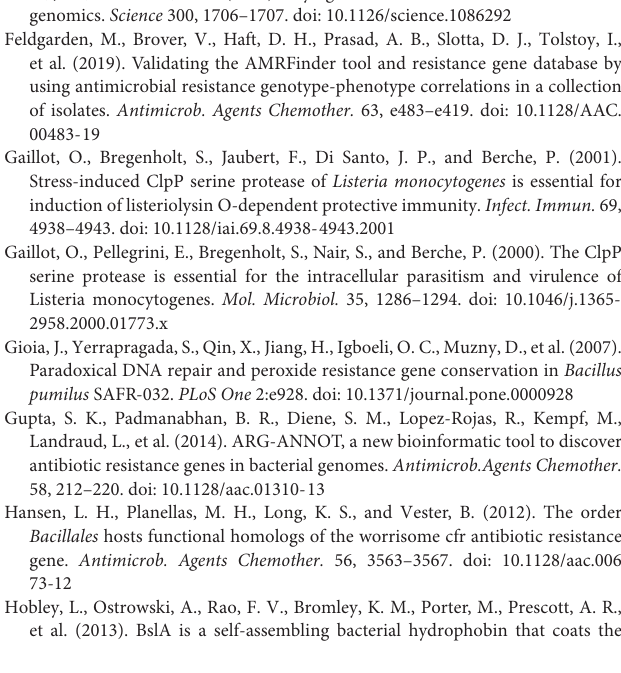
Supplementary Figure 1 | A flow chart representation of analyses conducted by different modules of PGCGAP v1.0.21, which integrates some popular software and in-house scripts (Liu et al., 2020). Supplementary Table 1 | Details of 96 B. amyloliquefaciens strains, including their genome size, GC%, scaffolds, CDS, its host and geographical location of the isolates, etc., retrieved from the NCBI database for comparative genome